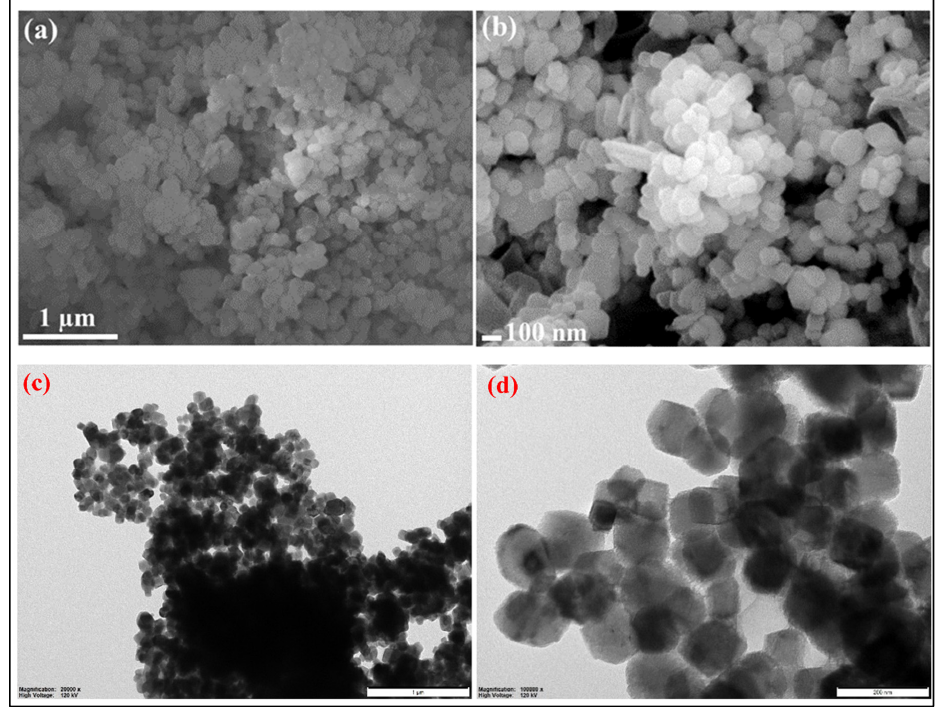
Figure 7. SEM-FES and TEM analyses of CaMg(CO 3 ) 2 . Notes: ( a , b ) SEM-FES images of the purified CaMg(CO 3 ) 2 at 1 μ m and 100 nm, ( c , d ) TEM images of CaMg(CO 3 ) 2 showing the particles’ shapes at